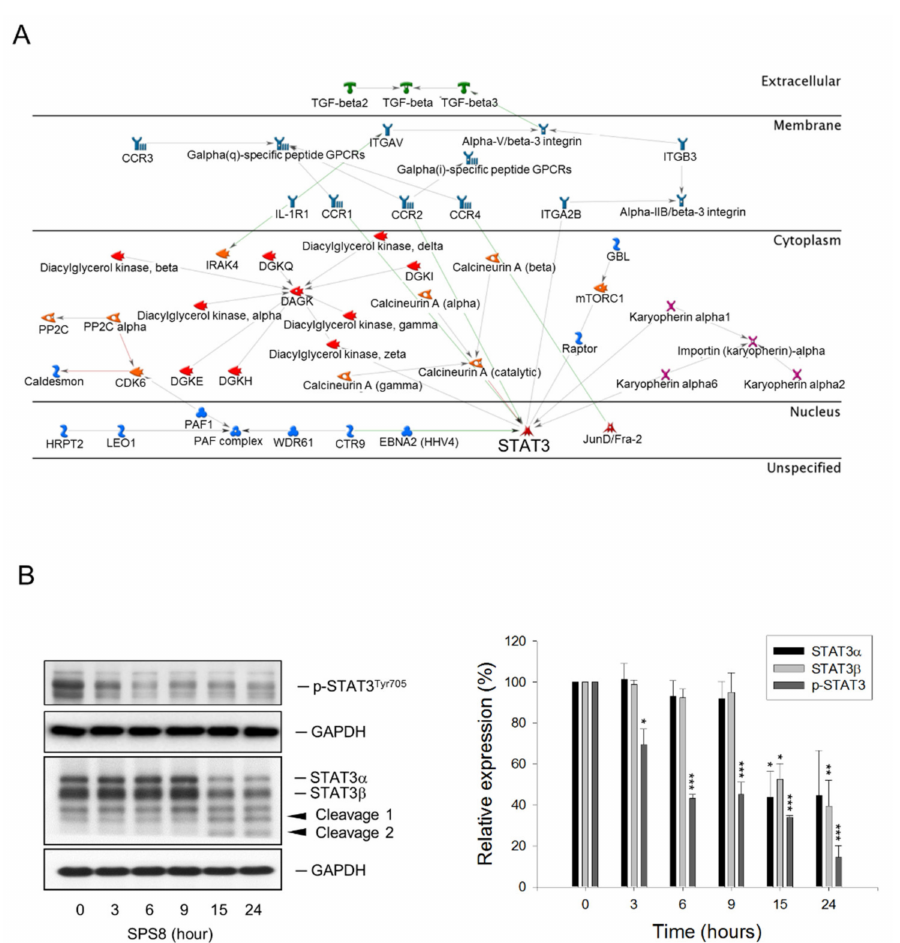
Figure 6. Proposed molecular pathways for SPS8 action. ( A ) The biological interactions of STAT3 co-expressed genes were analyzed by using Metacore. Red line, negative / inhibition e ff ects; Green line, positive / activation e ff ects. Gray line, unspecified e ff ects. ( B ) Western blot analysis of phosphorylated STAT3 and STAT3 α / β levels in HL-60 cells treated with SPS8 (5 µ M) for the indicated times. Data are expressed as the mean ± SEM of three independent experiments. * p < 0.05, ** p < 0.01, and *** p < 0.001 compared with the